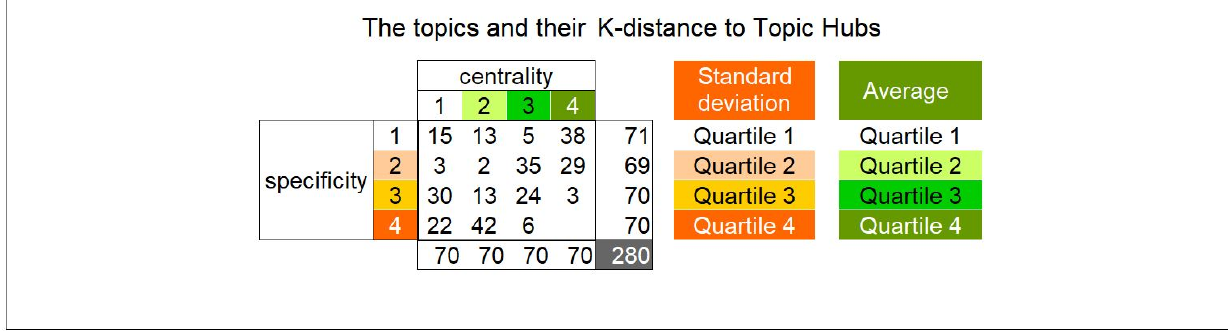
Figure 10. Classification of the topics in terms of relevance and specificity with respect to the nine topic hubs.